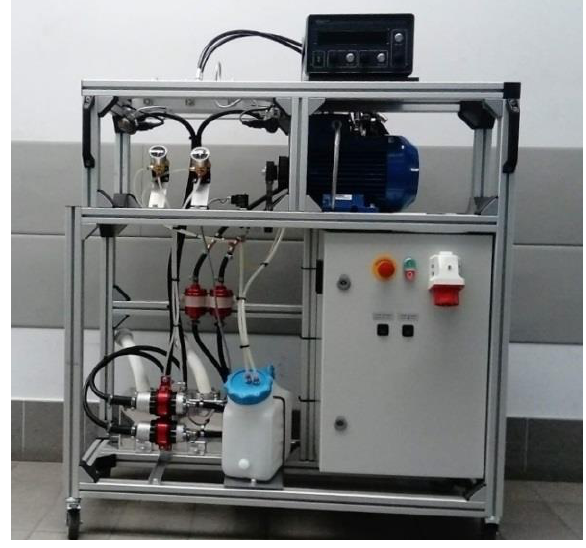
Fig. 9. High pressure pump stand with a fuel pressure regulation system The tests were carried out in the form of injecting the same fuel (Fig. 10a) and different fuels with the two injec- tors (Fig. 10b).